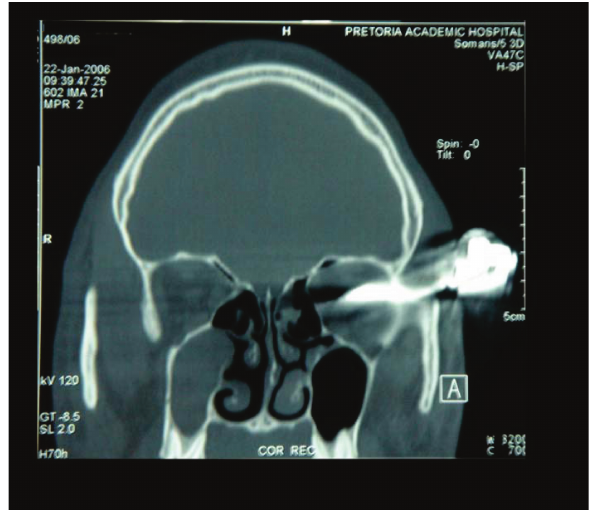
Figure 3 . CT, coronal view showing penetration of left